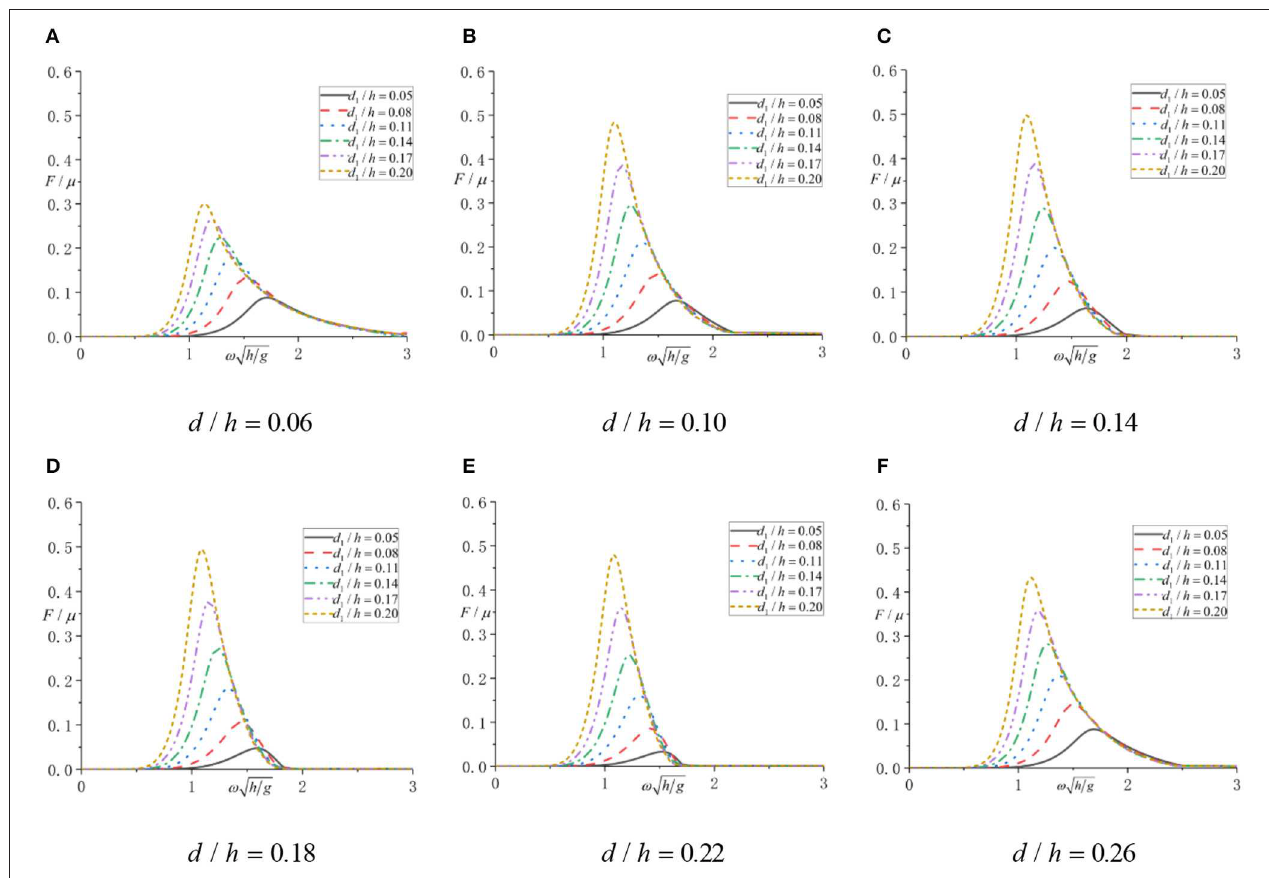
FIGURE 6 | F /µ of oscillating water column (OWC). (A) d / h